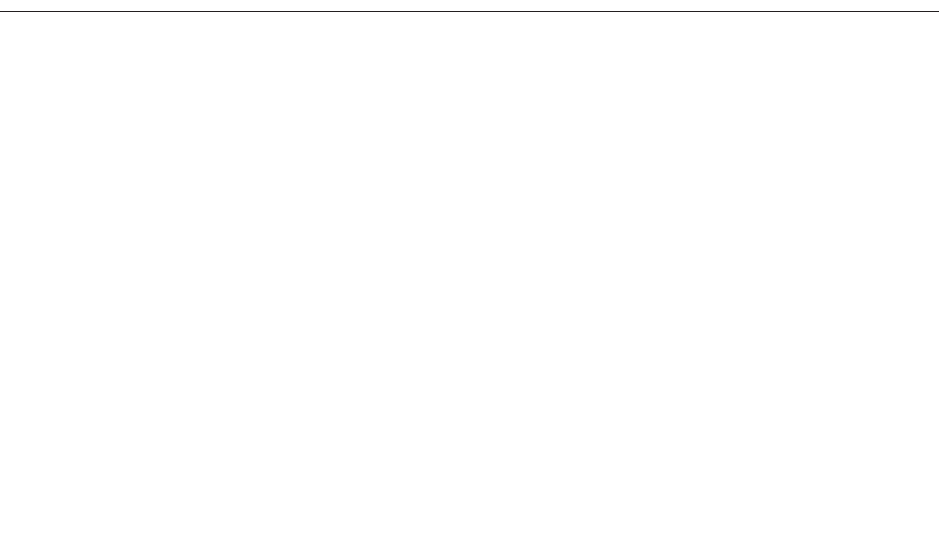
FIGURE A4 | LPS-stimulated MAPK